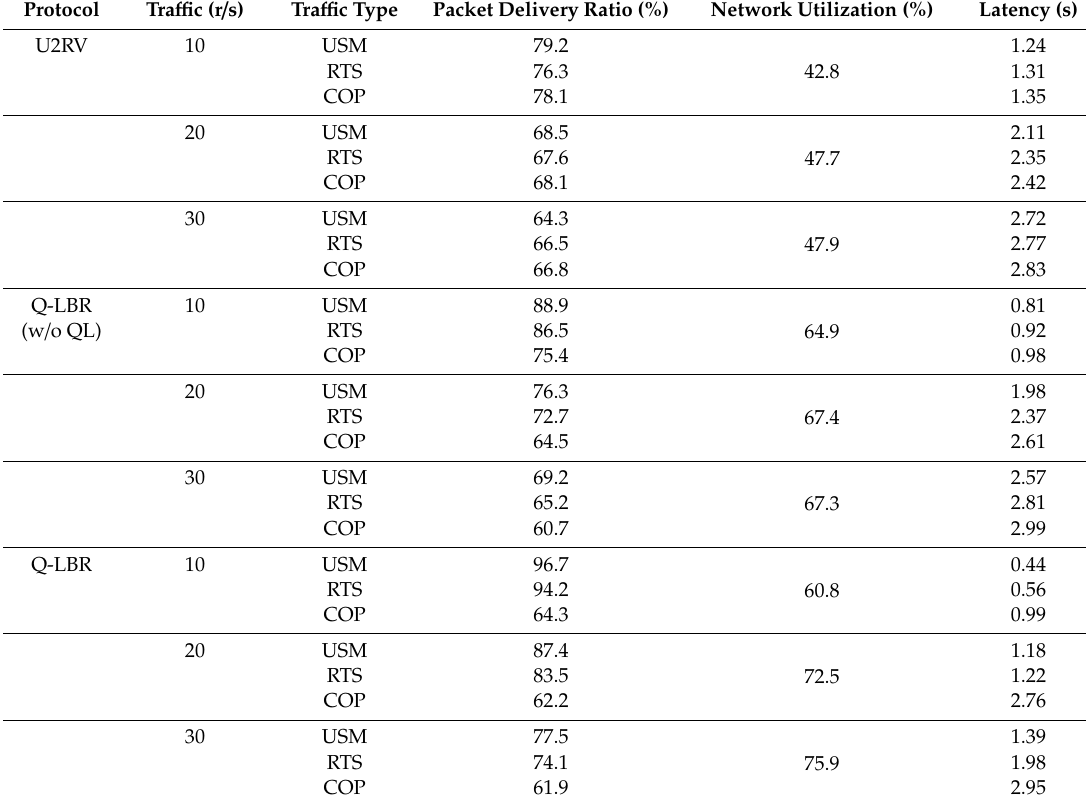
Figure 11. Performance comparison for traffic request rate: ( a ) total PDR, ( b ) total network utilization and ( c ) total latency. Table 4. Simulation results for varying the traffic request rate (speed = 0 s).